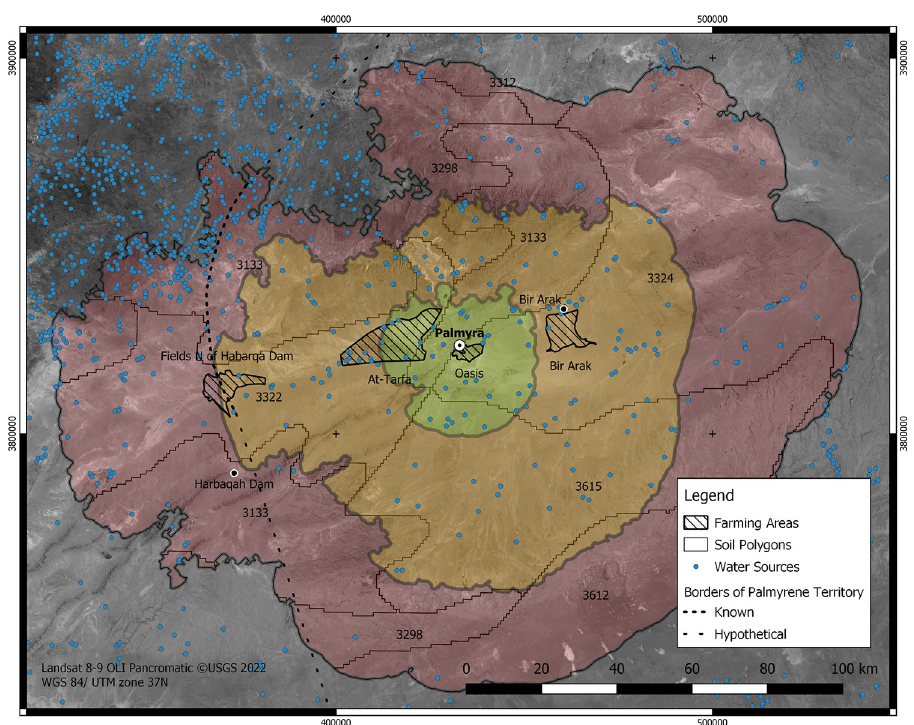
Fig 2. Map of the catchments around Palmyra. It shows areas within one day (green), one to three days (yellow) and five days (red) camel travel from the city. The numbers indicate each soil unit from the HWSD [61]. The striped areas are the maximum extent of fields in each of the main agricultural areas. Landsat 8–9 aerial imagery courtesy of the USGS, SPOT CIB-10 imagery was used for the analysis [62]. Water sources from Seland [63]. Palmyra territory’s boundary from Matthews